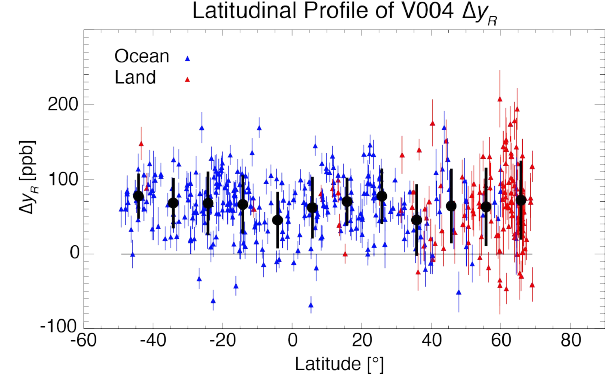
Fig. 4. Latitudinal profile of the difference 1y R between TES V004 and HIPPO methane concentrations (RTVMRs) during HIPPO I & II in January and October–November 2009. Symbols represent in- dividual HIPPO vertical profiles, and associated vertical bars are the theoretical error standard deviations reported in the TES retrievals. Black circles and vertical bars are the means and standard devia- tions of 1y R binned by 10 ◦ latitude. Fig. 5. Vertical profiles of V004 (top) and V005 (bottom) observed